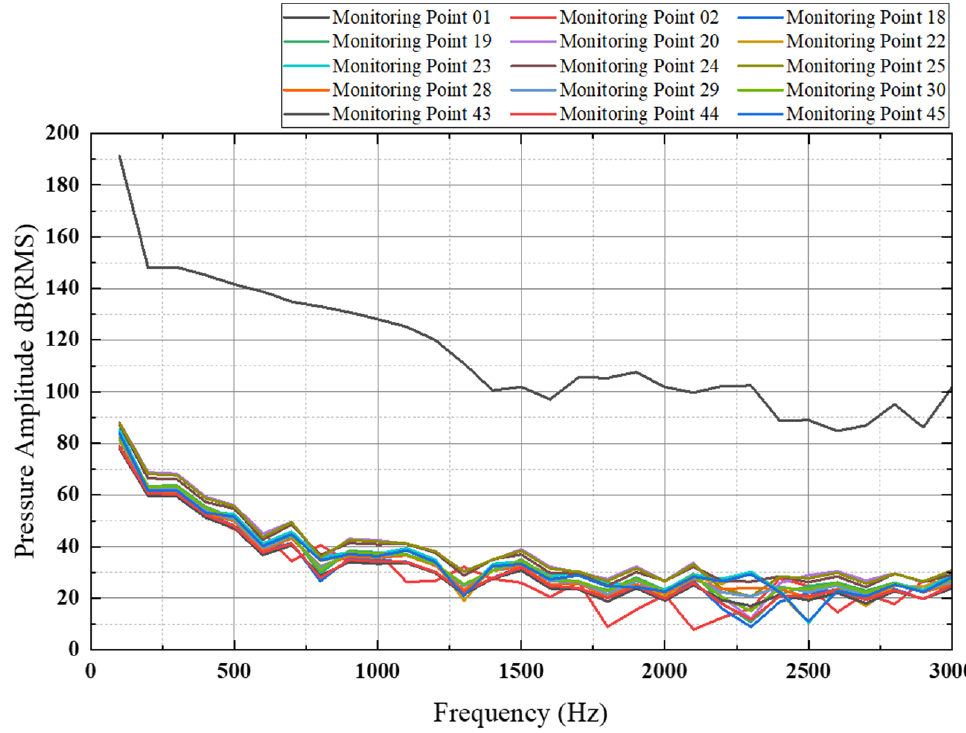
Figure 29. Line graph of the frequency response curve of the 3000 Hz far-field sound pressure level of the equal-diameter nozzle. Figure 30 is a line graph of the frequency response curve of the 3000 Hz near-field sound pressure level of the standard nozzle. According to the 3000 Hz far-field